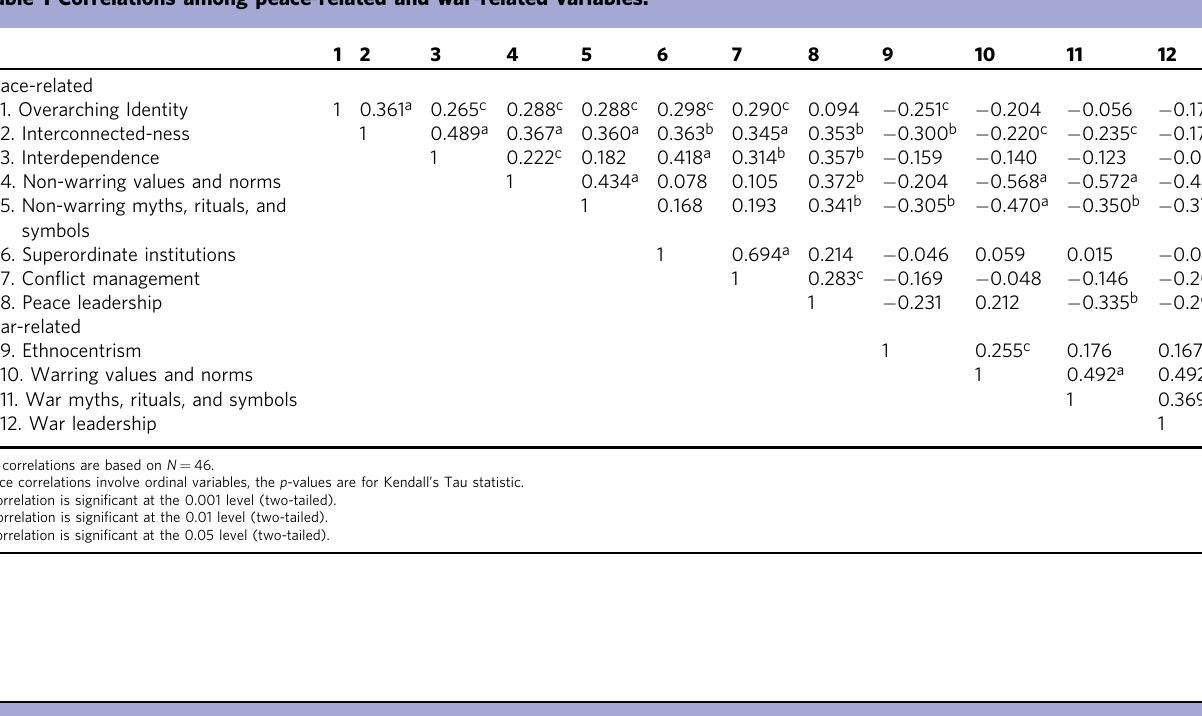
Table 2 Peace systems and non-peace systems compared regarding the primary peace-related and war-related variables.